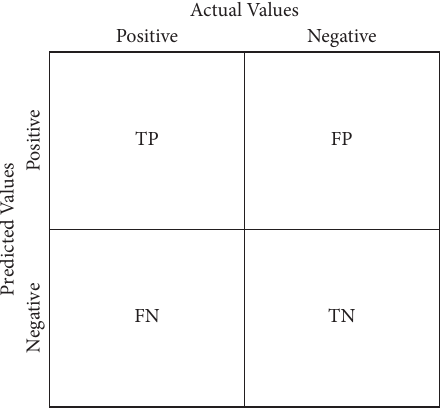
Figure 9: A representation of the confusion